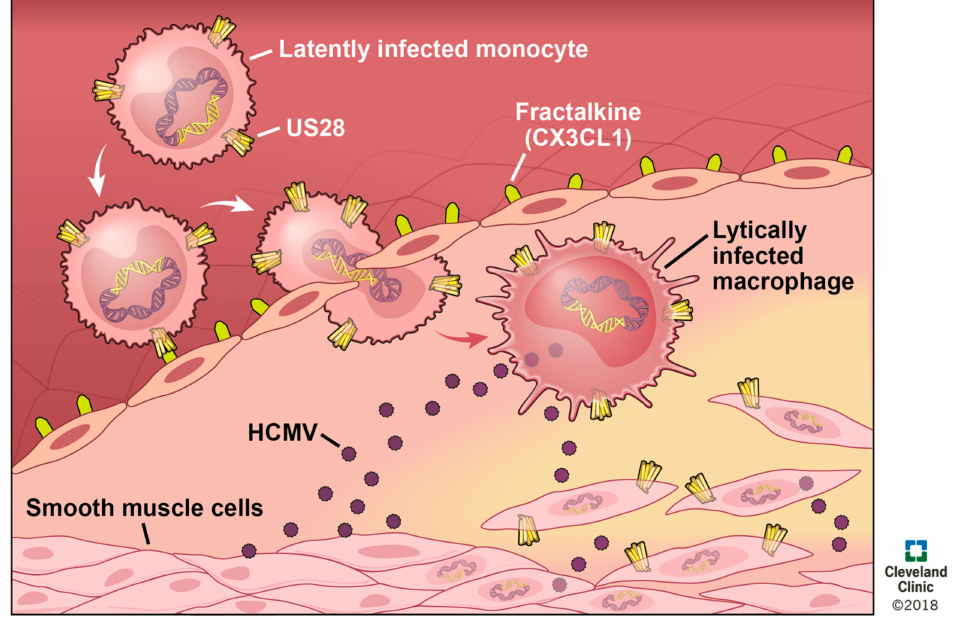
Figure 4. A model of pUS28’s role during atherosclerotic plaque formation. Monocytes are recruited to the injured endothelium, after which they extravasate through the endothelium into the intima, resulting in their differentiation to macrophages. SMCs then migrate towards the site of the developing plaque in response to pro-inflammatory signals. pUS28 expressed from latently infected monocytes can interact with fractalkine, upregulated on the endothelium, thus enhancing the binding of these cells. The differentiation of these cells to macrophages will result in lytic replication, capable infecting neighboring cells (e.g., macrophages, endothelial cells, and SMCs). Infection of SMCs leads to pUS28 expression, which is sufficient to induce the migration of this cell type [62]. Together, it is possible that HCMV, and specifically pUS28, could accelerate the cellular processes that lead to plaque